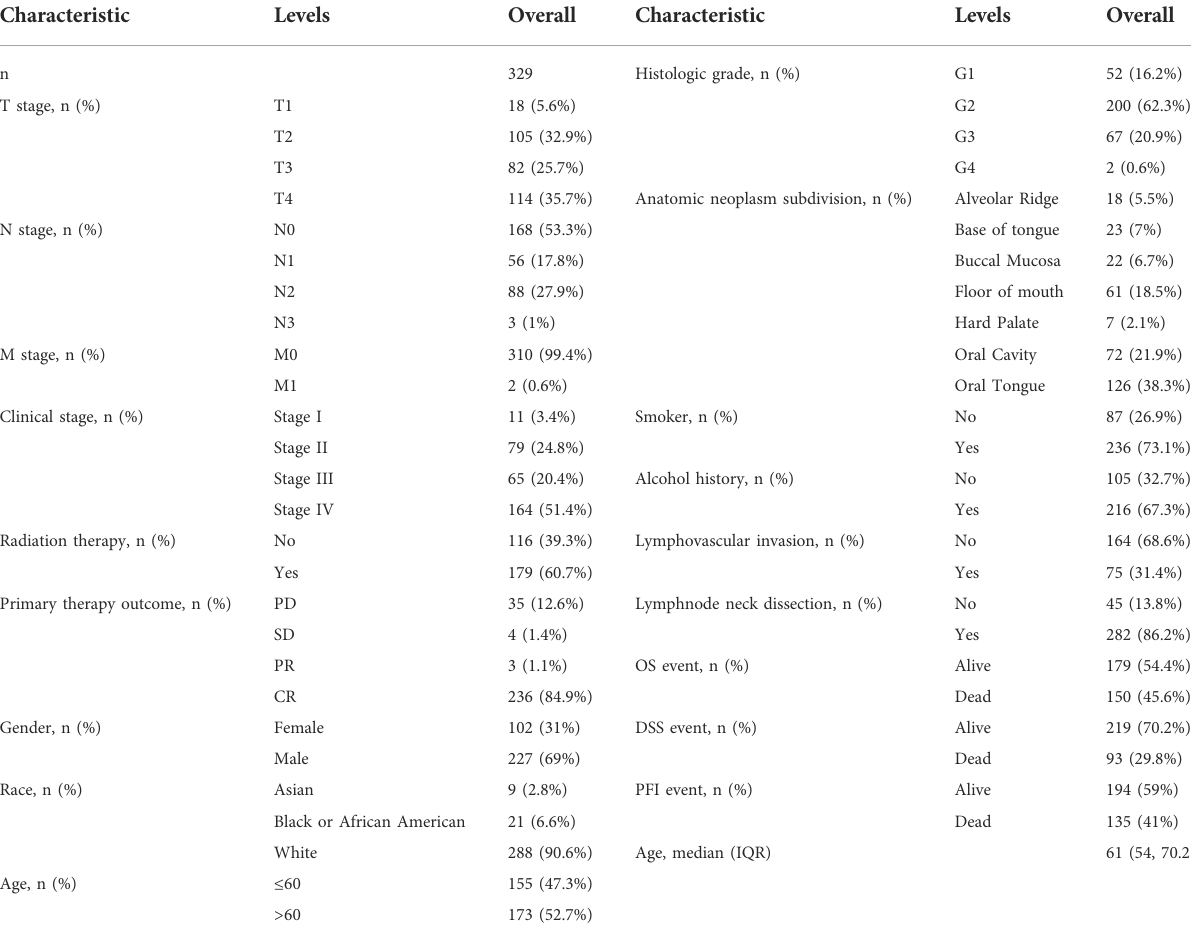
TABLE 1 Clinical characteristics of OSCC patients.